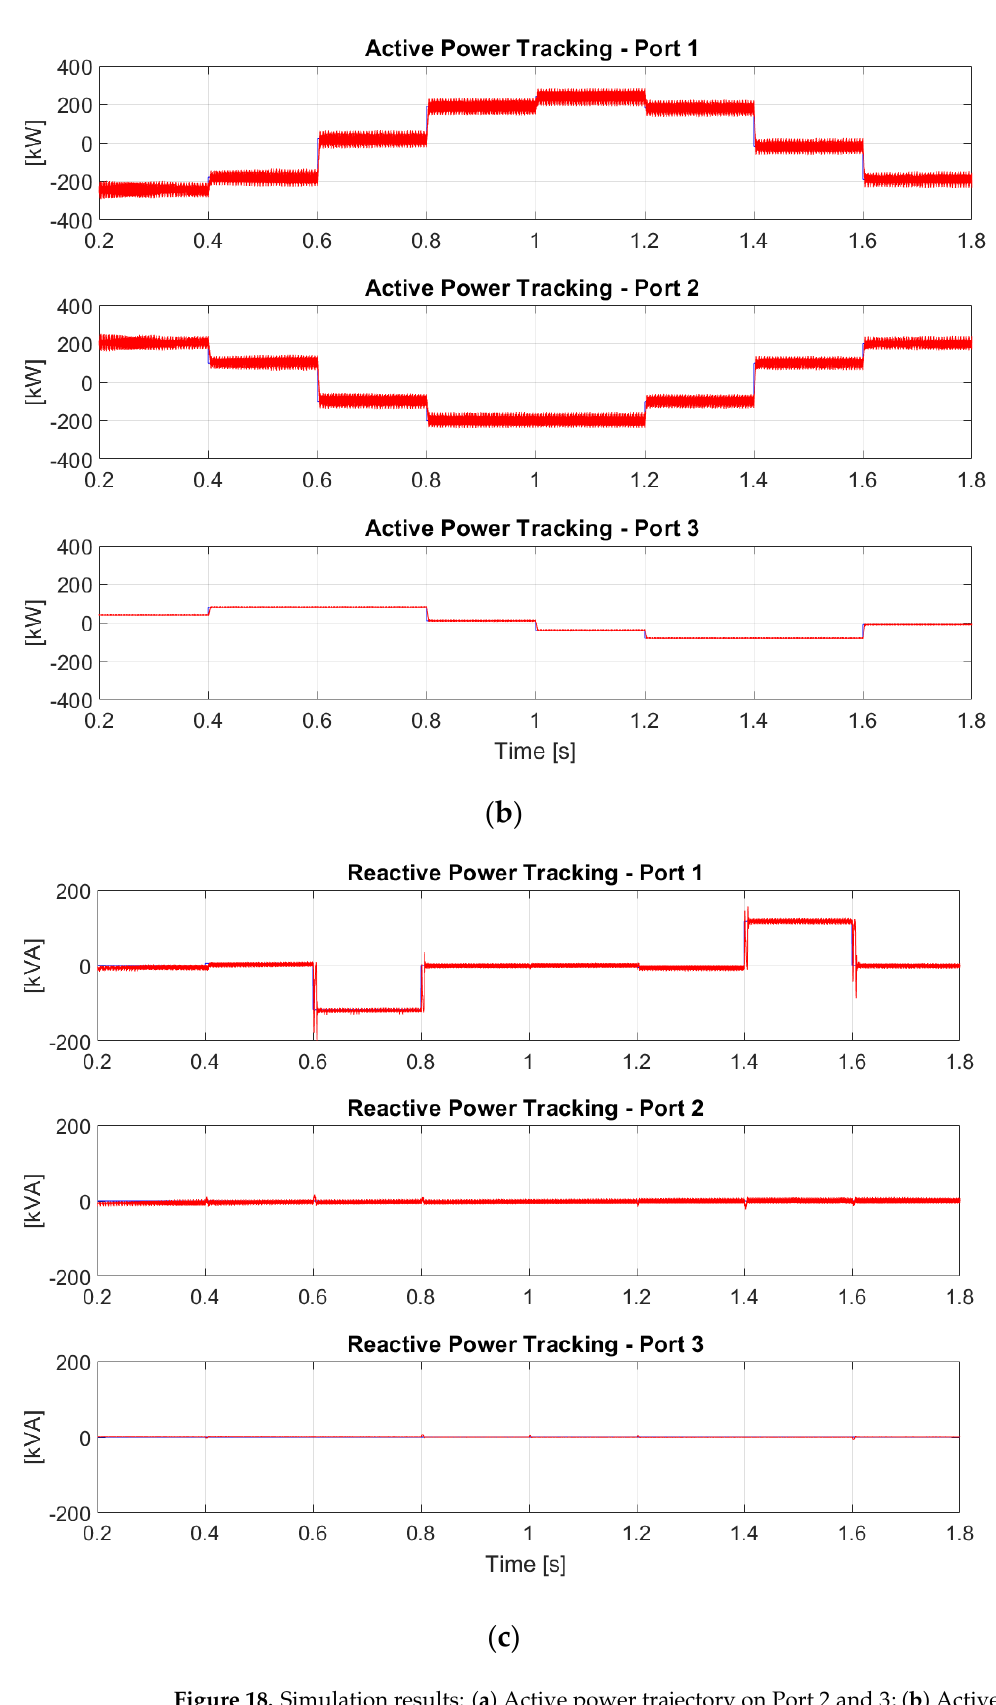
Figure 18. Simulation results: ( a ) Active power trajectory on Port 2 and 3; ( b ) Active power tracking on Port 1, 2, and 3; ( c ) Reactive power tracking on Port 1, 2, and 3.